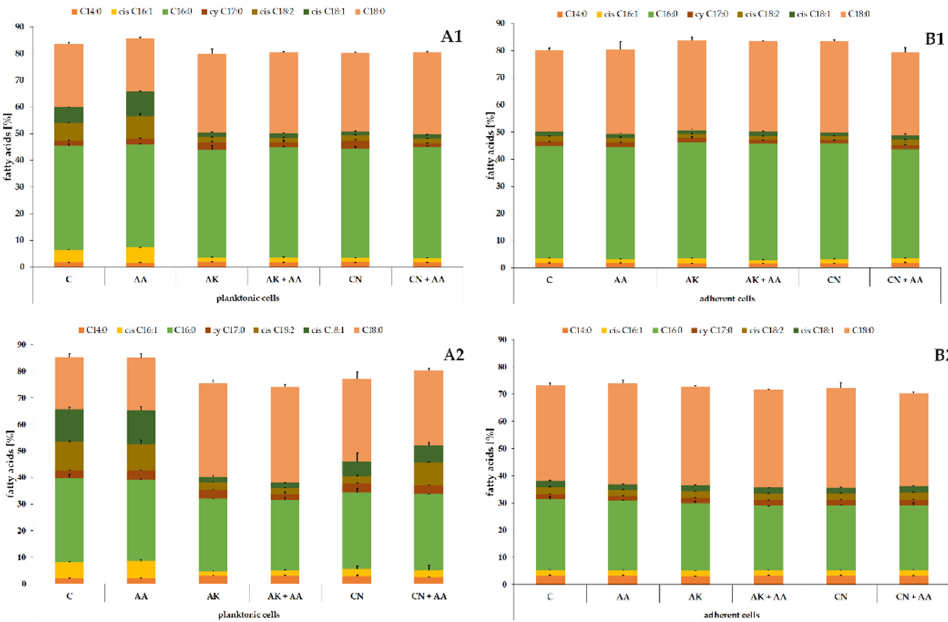
Figure 4. Percentage contents of FAs identified in the planktonic ( A ) and adherent ( B ) cells of the ATCC 29906 ( 1 ) and C12 ( 2 ) strains treated with ascorbic acid and/or aminoglycosides. Legend: C—control, AA—ascorbic acid, AK—amikacin, CN—gentamicin.